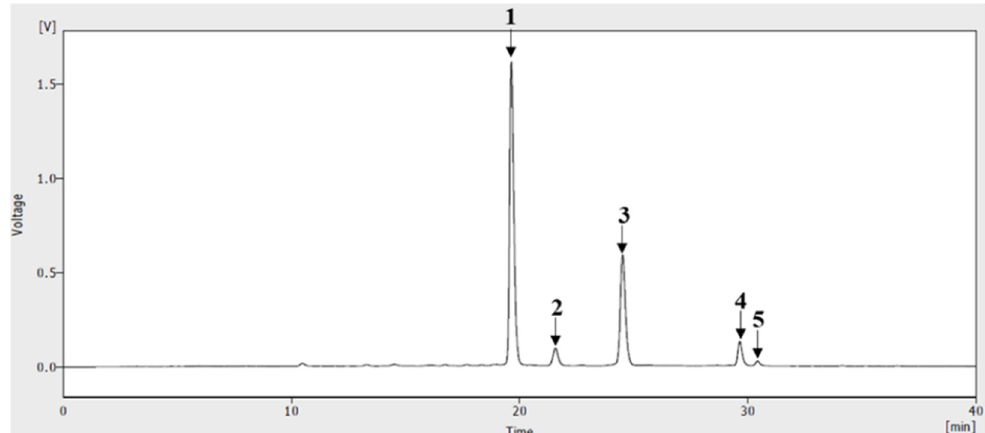
Appl. Sci. 2021 , 11 , x FOR PEER REVIEW Figure 1. HPLC-UV chromatogram of the Aronia bioactivity fraction (ABF ® ). 1. cyanidin-3-galacto- Figure 1. HPLC-UV chromatogram of the Aronia bioactivity fraction (ABF ® ). 1 . cyanidin-3-galactoside; 2 . cyanidin-3- side; 2. cyanidin-3-glucoside; 3. cyanidin-3-arabinoside; 4. cyanidin-3-xyloside; and 5. cyanidin chlo- glucoside; 3 . cyanidin-3-arabinoside; 4 . cyanidin-3-xyloside; and 5 . cyanidin chloride. ride.